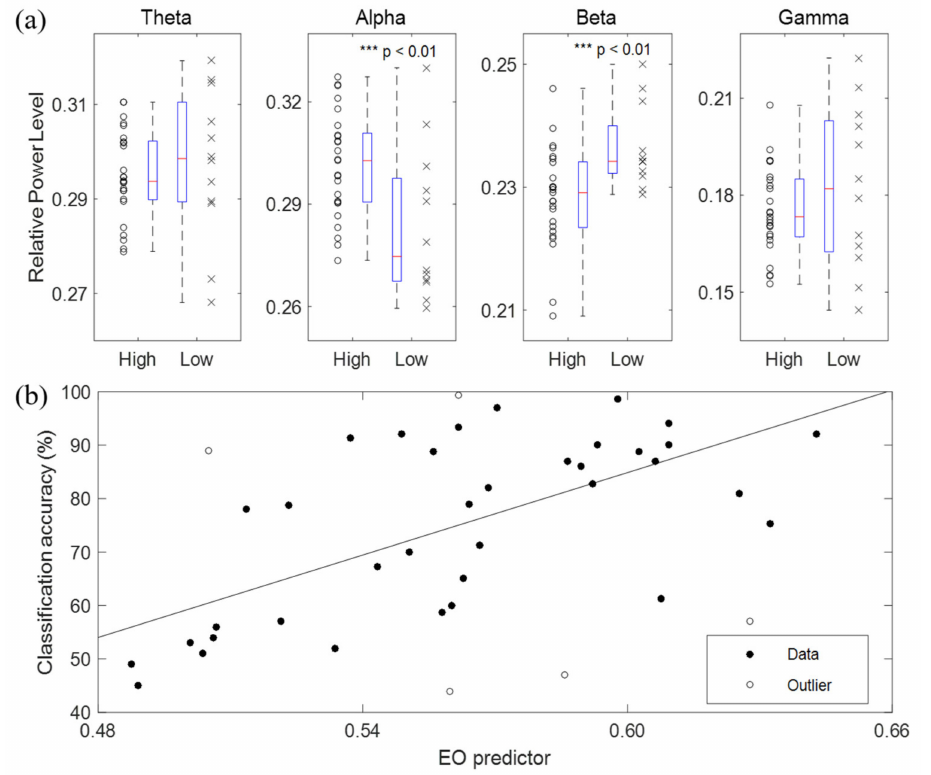
Figure 2. Eyes-open resting state: ( a ) The RPL distributions of theta, alpha, beta, and gamma powers between the high- and low-performance groups. ( b ) Regression analysis between the EO predictor with three frequency bands (theta, alpha, and beta) and online BCI classification